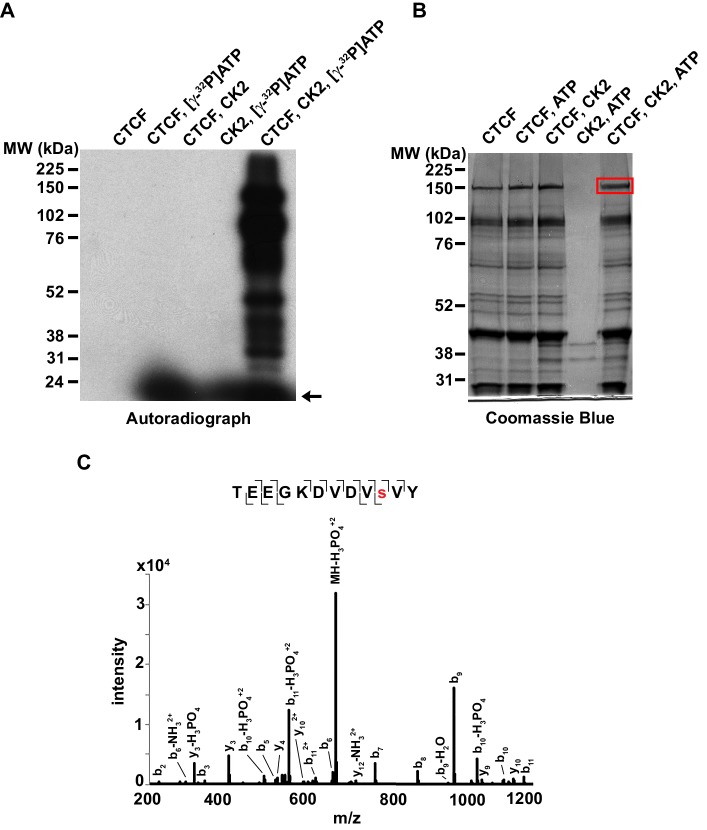
Casein kinase 2 (CK2) can phosphorylate CTCF Ser224.(A) In vitro kinase assay autoradiograph of recombinant FLAG-CTCF-6xHis phosphorylated by CK2 with [γ-32P]ATP. Black arrow, free [γ-32P]ATP. (B) Coomassie Blue stained gel of FLAG-CTCF-6xHis phosphorylated with CK2 and cold ATP performed in parallel as in A. Red box, Full-length FLAG-CTCF-6xHis band excised for mass spectrometry analysis. (C) Manually validated mass spectra of CTCF peptide Thr215-Tyr226 with y and b ions identified. Phosphorylation at Ser224 indicated by red s.